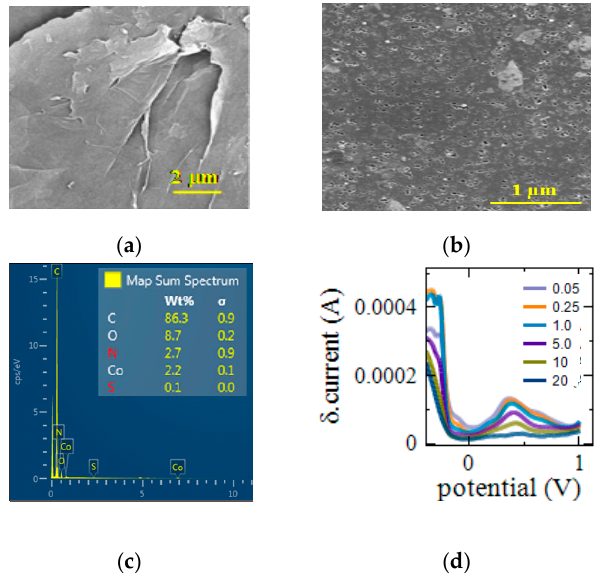
Figure 1. SEM images of ( a ) GO and ( b ) Co-rGO/P C , ( c ) EDS data of Co-rGO/P C , and ( d ) DPV measurement data in different concentration of MN (mg L -1 ) measured with Co-rGO/P C